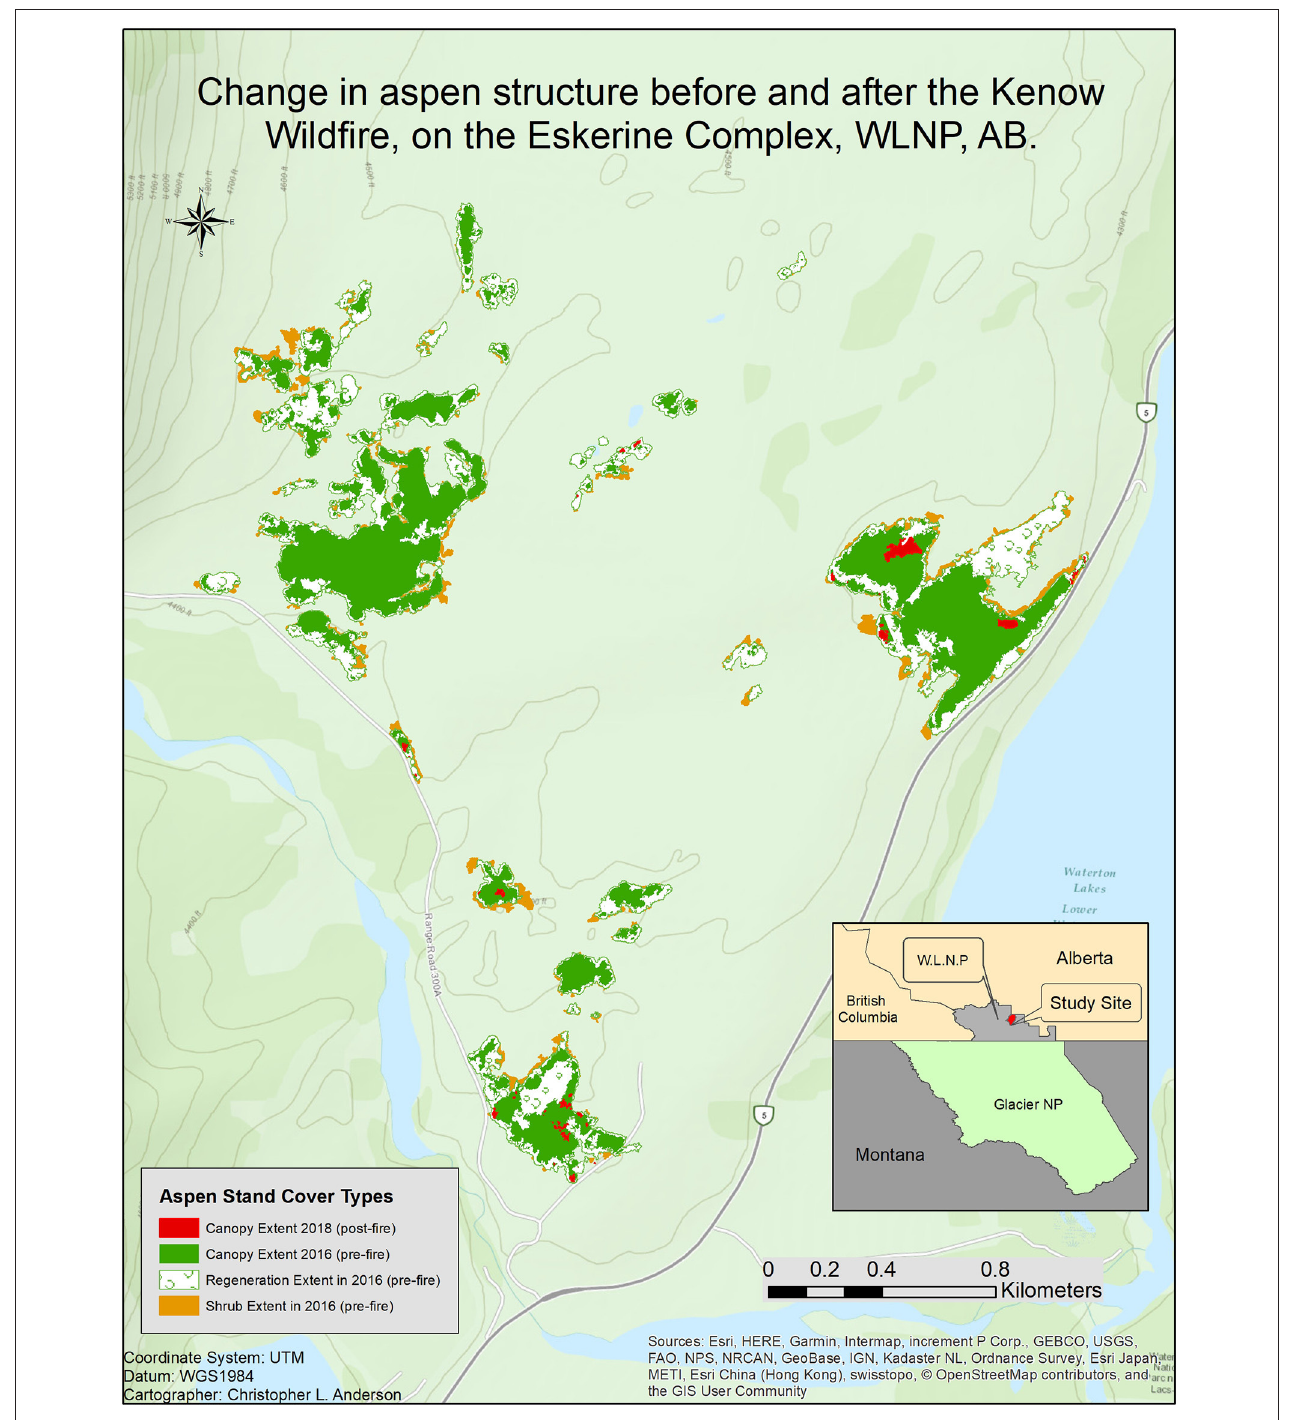
FIGURE 5 | Change in Aspen Stand Structure, map by Christopher L. Anderson and Curtis B. Edson.